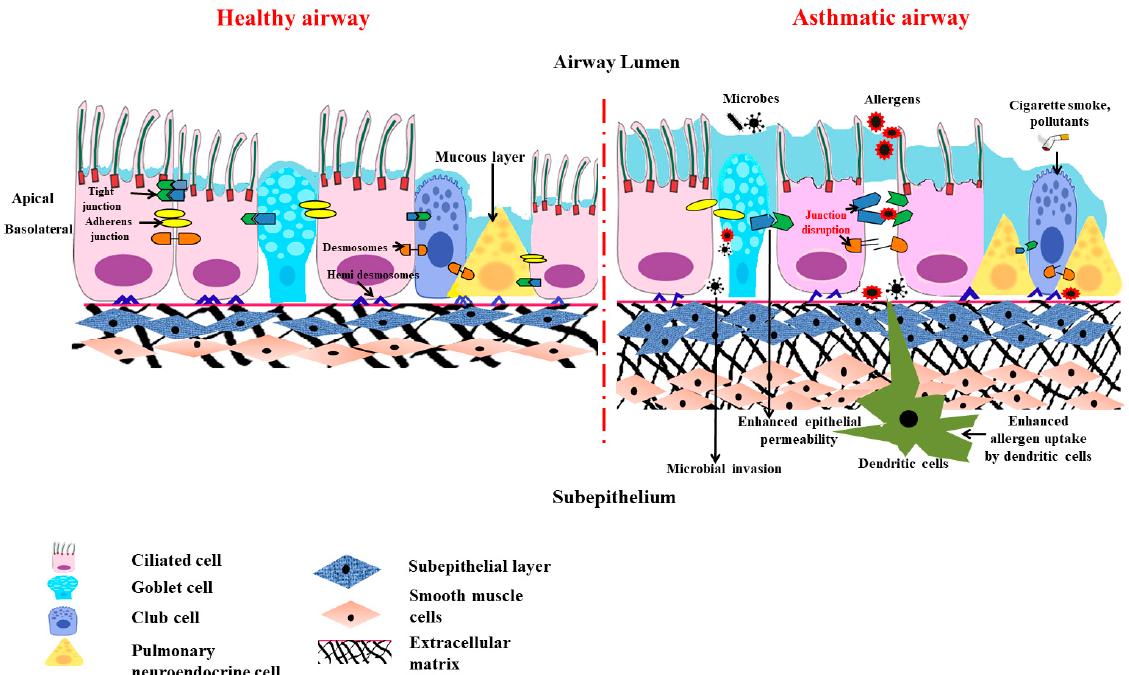
Figure 2. Scheme diagram to illustrate the structural changes in the airway epithelial barrier in asthmatics compared to healthy airway epithelium. When the asthmatic airway epithelium is exposed to allergens and air pollutants, it causes disruption to the tight epithelial junction and adherens junction. This leads to heightened mucosal permeability, effectuating more inhaled particles and allergens present in the subepithelial region and promoting innate and adaptive immune responses. This is accompanied by PNEC hyperplasia, a loss of ciliated cell numbers, goblet cell metaplasia, mucus hypersecretion, the thickening of the basal membrane, subepithelial fibrosis, increased airway smooth muscle mass, and the excess deposition of extracellular matrix.